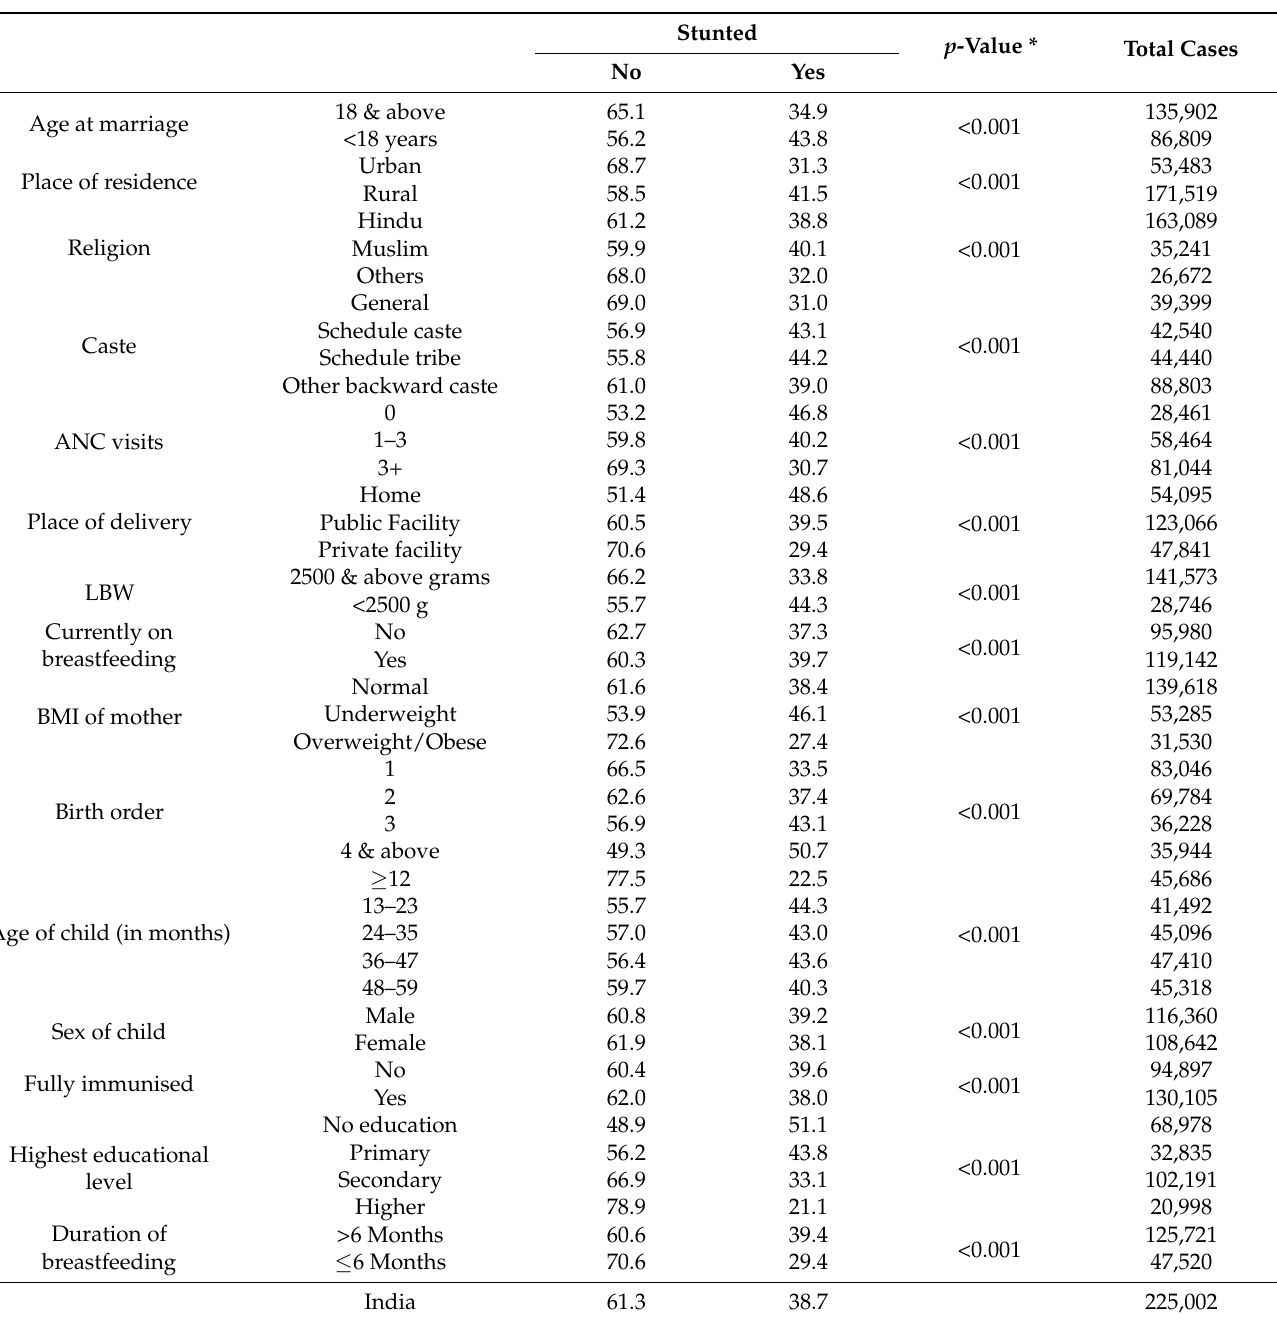
Table 1. Prevalence (%) of stunting among Indian children by background